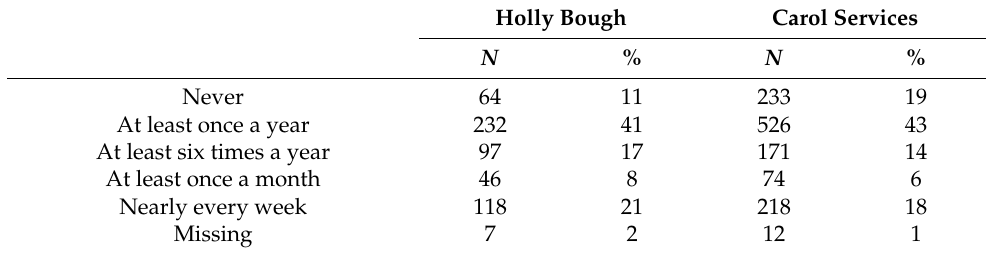
Table 10. Public worship